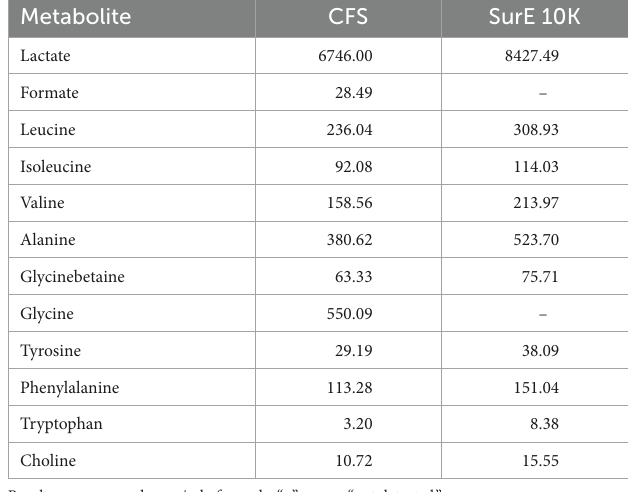
Results are expressed as μ g/ml of sample. “–” means “not